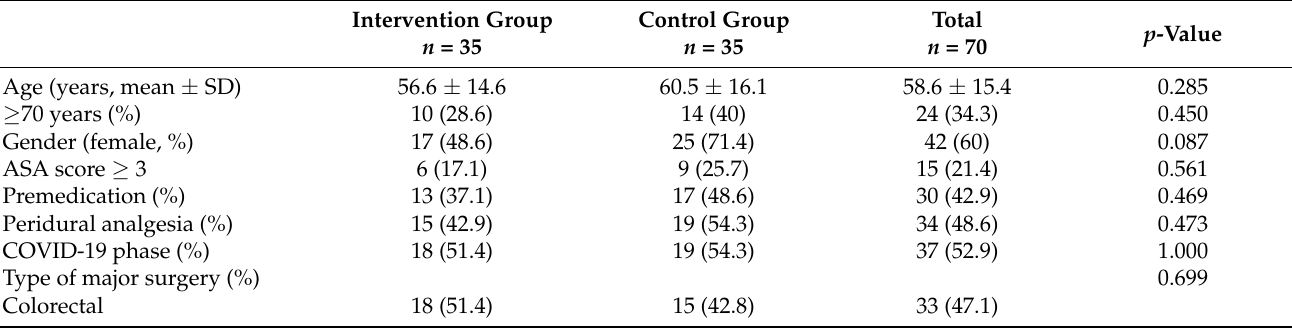
Figure 1. Study flowchart. STAI-Y-A: State-Trait Anxiety Inventory Form Y-A. Table 1. Demographics and surgical Table 1. Demographics and surgical details.